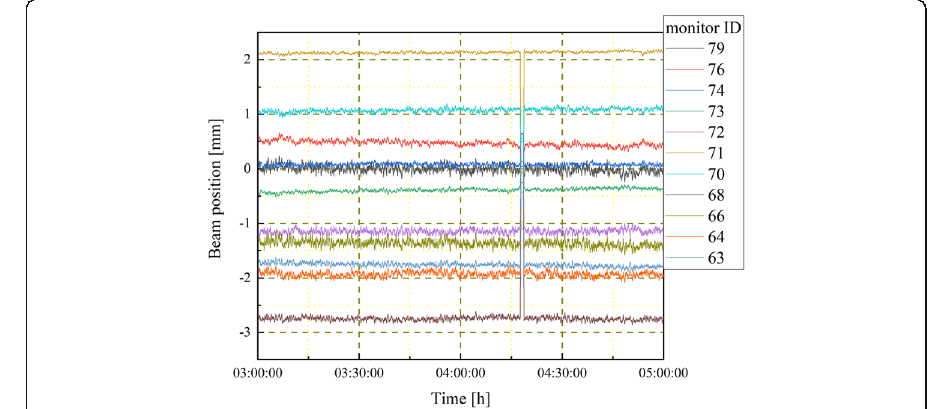
Fig. 7 Beam position data of all position monitors in